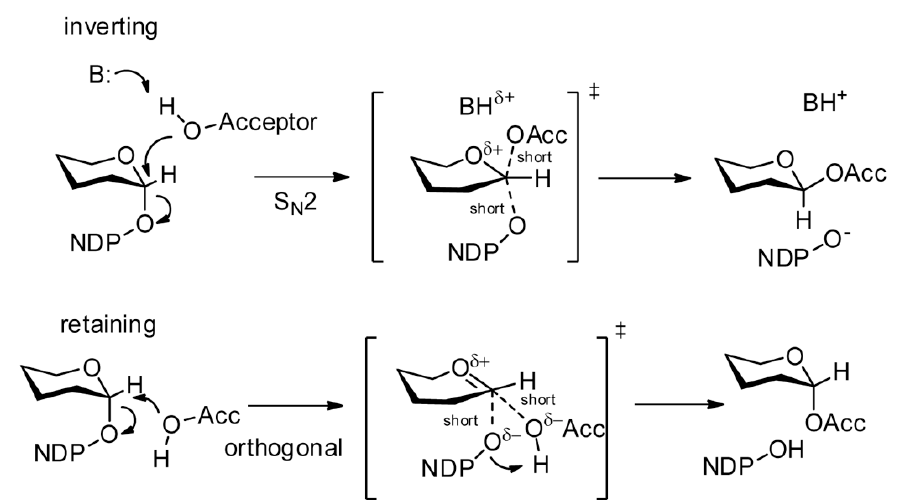
Figure 2. Glycosyltransferase mechanisms. An S N2 (substitution, nucleophilic, bimolecular) process is accepted for inverting glycosyltransferases (GTs). Several mechanisms have been proposed for retaining enzymes. The orthogonal mechanism is depicted here. ‡: Transition state. Image by Dr.